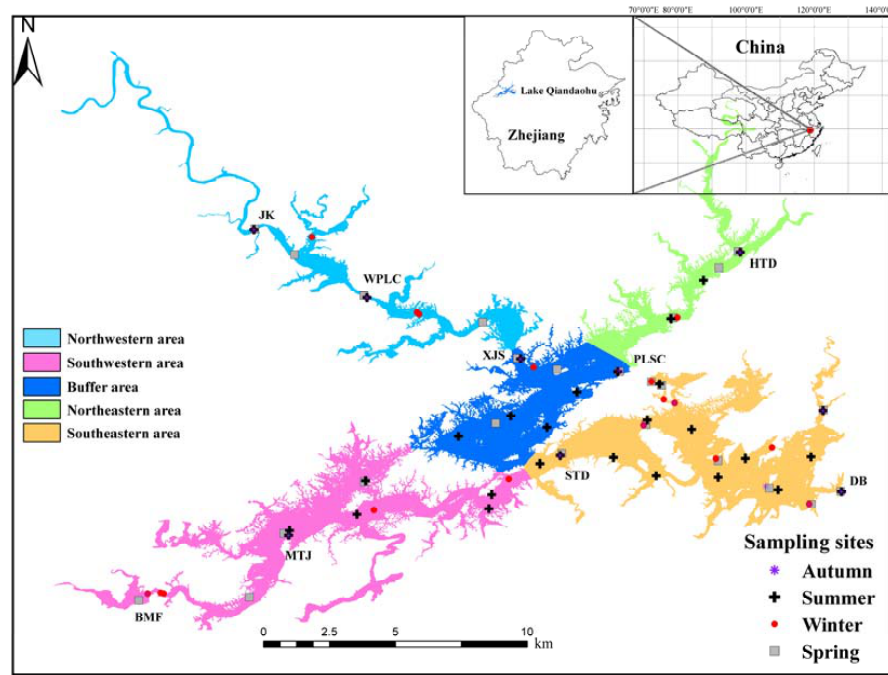
Figure 1. Map of Lake Qiandaohu and the locations of the seasonal sampling sites.